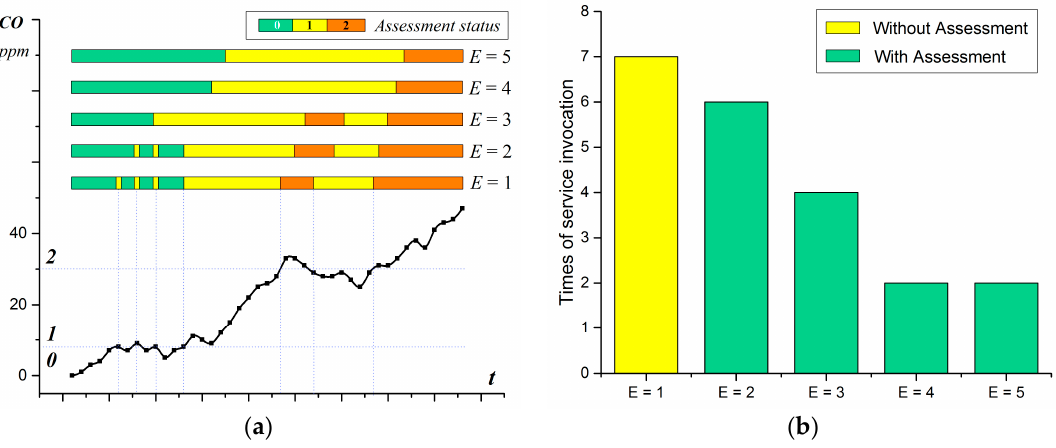
Figure 10. Assessment result as the valid quantity increases from 1 to 5 during the CO observation: ( a ) Assessment status; and ( b ) Times of services invocation.